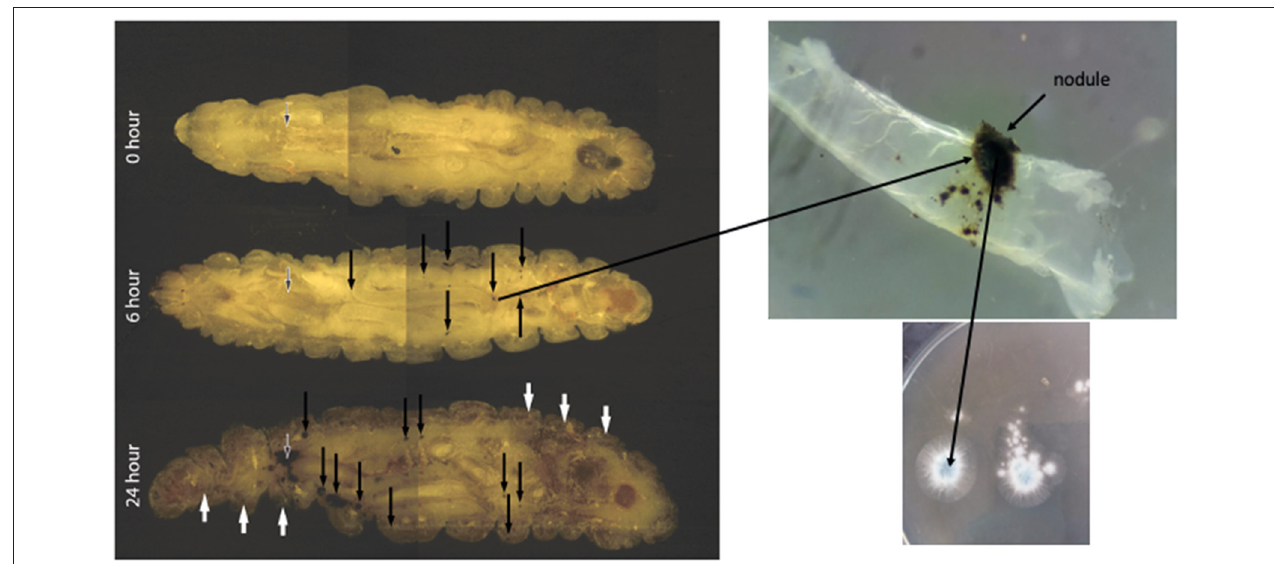
FIGURE 6 | Cryoviz visualisation of the stages of invasive and disseminated aspergillosis in G. mellonella larvae after 6 and 24h infection. Larvae were inoculated with 1 × 10 6 A. fumigatus conidia and embedded in Cryo-imaging embedding compound and sectioned (10 µ m) using a Cryoviz TM cryo-imaging system (Fungal nodules—black arrows; cuticle melanisation- white arrows; point of inoculation—white edged black arrow) (Image courtesy of Dr. Gerard